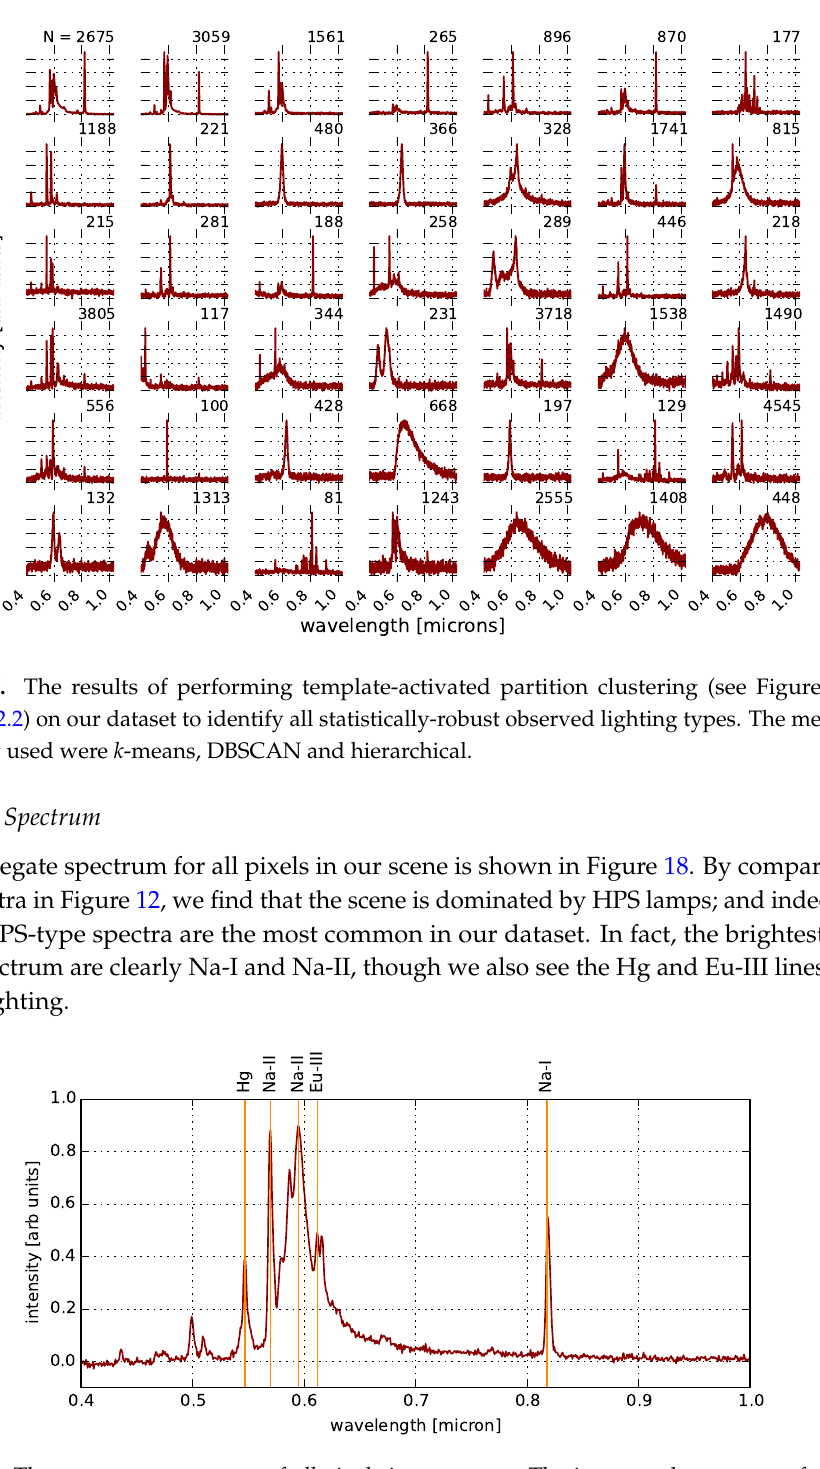
Figure 18. The aggregate spectrum of all pixels in our scene. The integrated spectrum of the NYC skyline is dominated by HPS-type lighting with strong peaks in the Na-I and Na-II bands, though we also identify Hgand Eu-III lines that are common in fluorescent